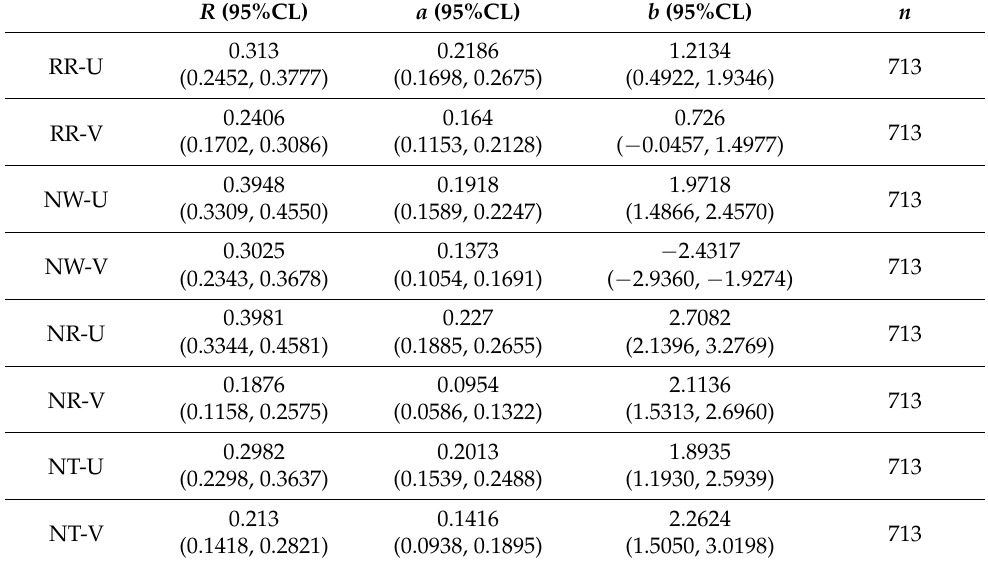
Table 3. Comparison metrics (scalar correlation coefficient R , slope and intercept of the linear best fit model) for the model–drifter data, separate for the U (V) velocity components, along with the 95% confidence levels (CL) and the number of samples ( n ) used in the comparisons. Summary is provided for the model runs reported in Table